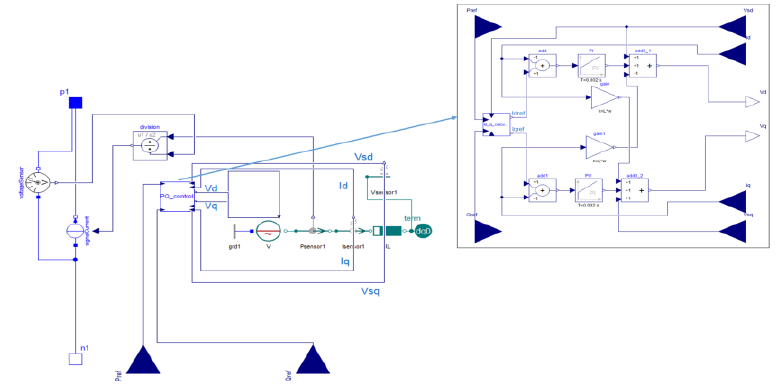
Figure A7. Modelica’s average inverter model.